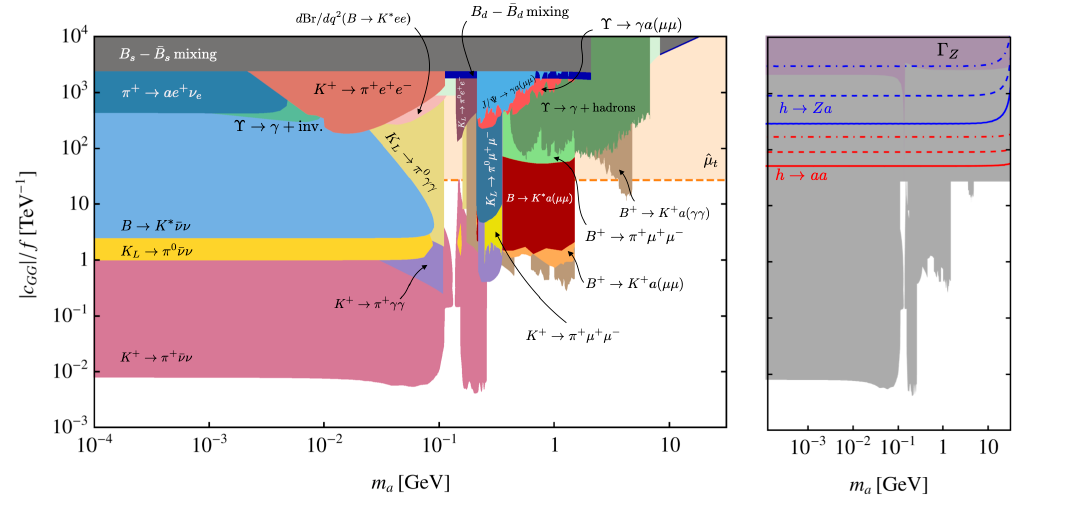
Figure 19 . Left: flavor bounds on ALP couplings to gluons with all other Wilson coefficients set to zero at Λ = 4 πf and f = 1 TeV. Right: comparison of the same flavor constraints (light gray) with the constraints on Z → aγ decays from the LEP measurement of the Z boson width (violet), contours of constant Br ( h → aa ) = 10 − 1 , 10 − 2 and 10 − 3 , depicted as red dotted, dashed and solid lines, and contours of constant Br ( h → Za ) = 10 − 1 , 10 − 2 and 10 − 3 , shown as blue dotted, dashed and solid lines,